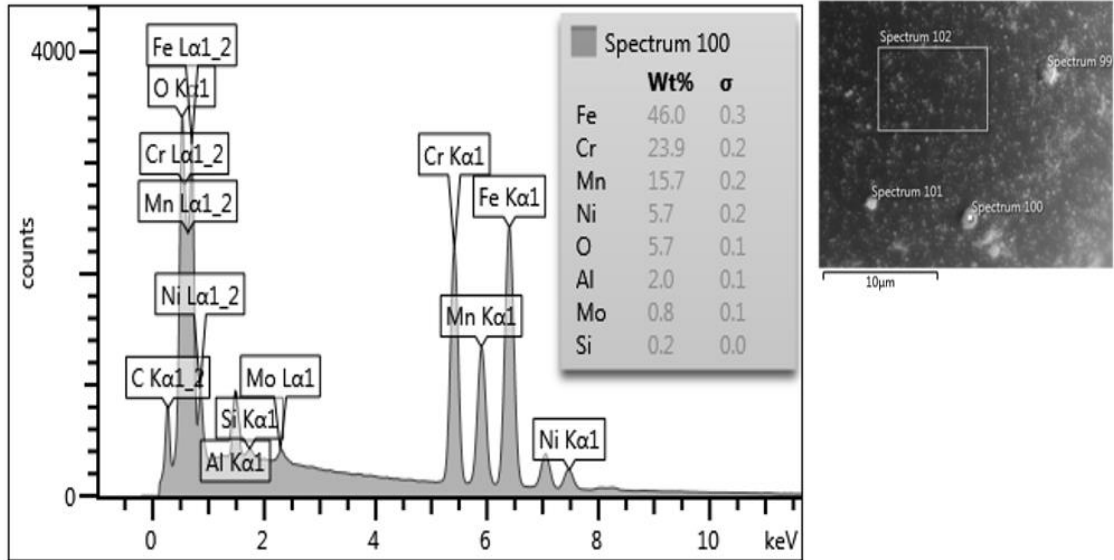
Figure 5. The EDS tests results of one of the spots in the 316L grain surface.